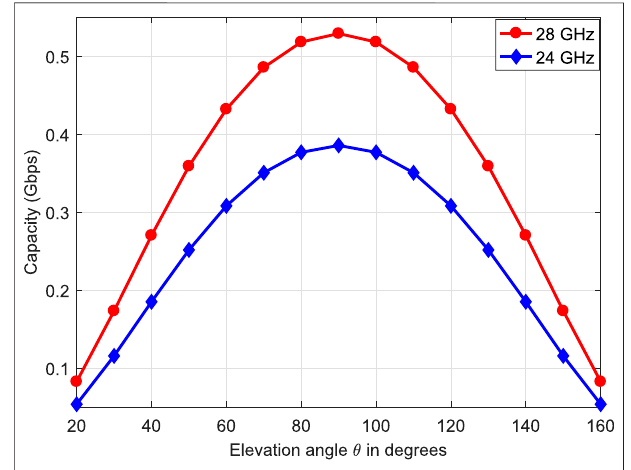
FIGURE 6 | Capacity vs. elevation angle for the HAP-to-eVTOL link